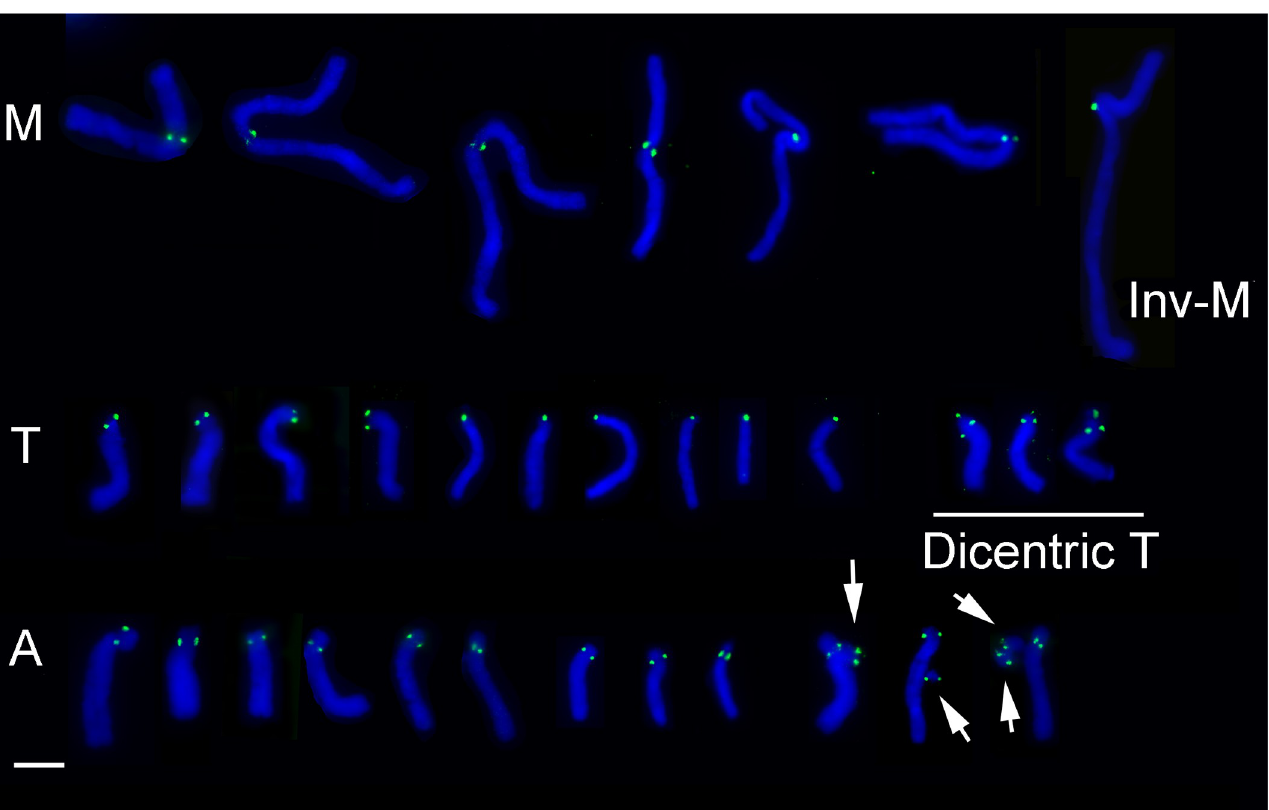
Fig 7. Immunoassay of LaCENH3 showing specificity at centromeres of Lycoris chromosomes. (Scale bar = 10 μ m). Immunofluorescence signals (green) are specifically present at the centromeres of M-type, T-type, and A-type chromosomes. Note that the centromere position changed on Inv-M due to pericentric inversion on an M-type chromosome. Immuno-signals on the micronuclei (arrows), which were coincidently and random near these A-type chromosomes, confirm the presence of functional centromeres. Two green signals on some T-type chromosomes, one at the distal end of short arm (arrowhead) and one at the proximal end of the long arm (double arrowheads), suggest the existence of two functional centromeres (dicentric-T).